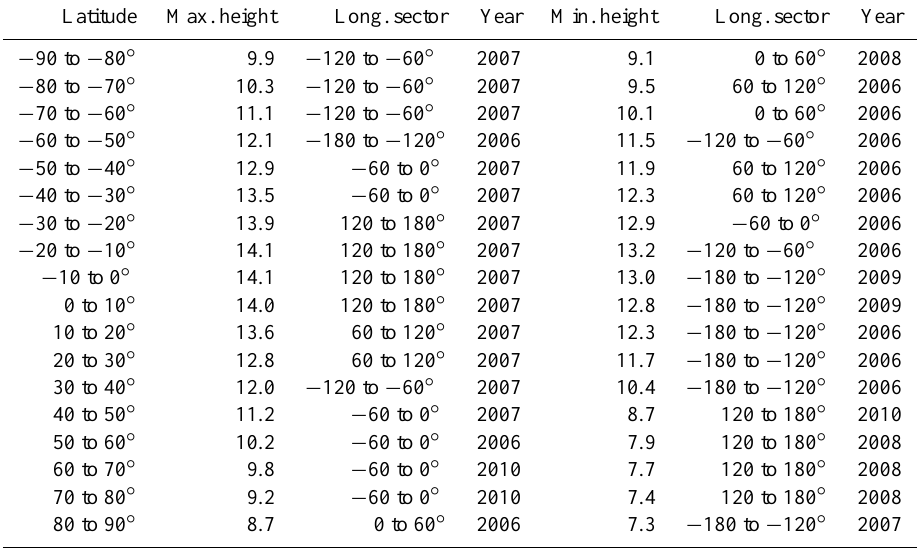
Figure 6. Temporal evolution of differences between dry and physical temperature ( T diff ) for the model BCC-CSM1.1(m) from the Beijing Climate Center. The left column shows 10 ◦ zonal mean climatological fields from 2006 to 2010 and the right column from 2046 to 2050, for T diff = − 0 . 1K. Table 2. January: maximum height, corresponding longitude sector and year and minimum height, corresponding longitude sector and year for T diff = − 0 .